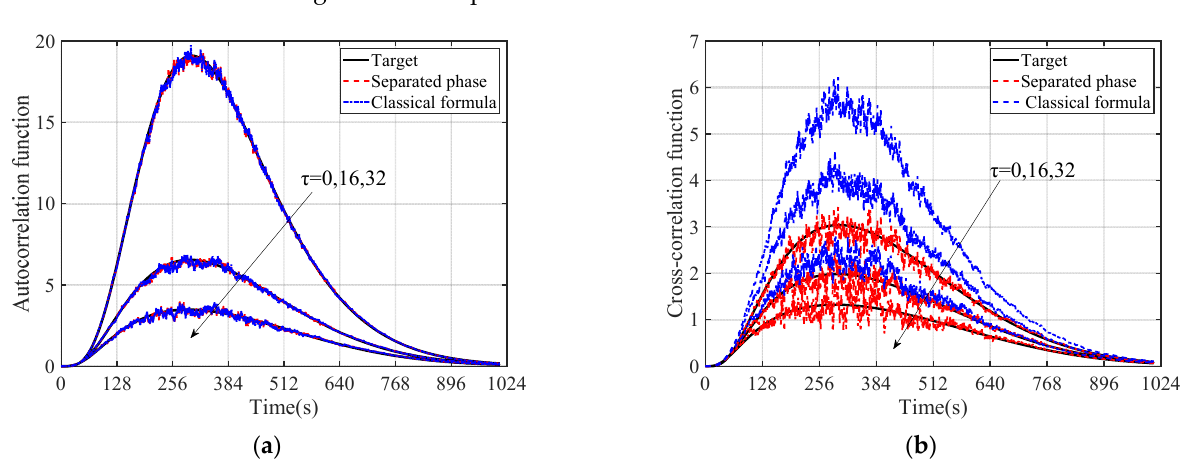
Figure 8. Estimated correlation functions by time-invariant coherent nonstationary wind fluctuation samples (1000 samples): ( a ) R